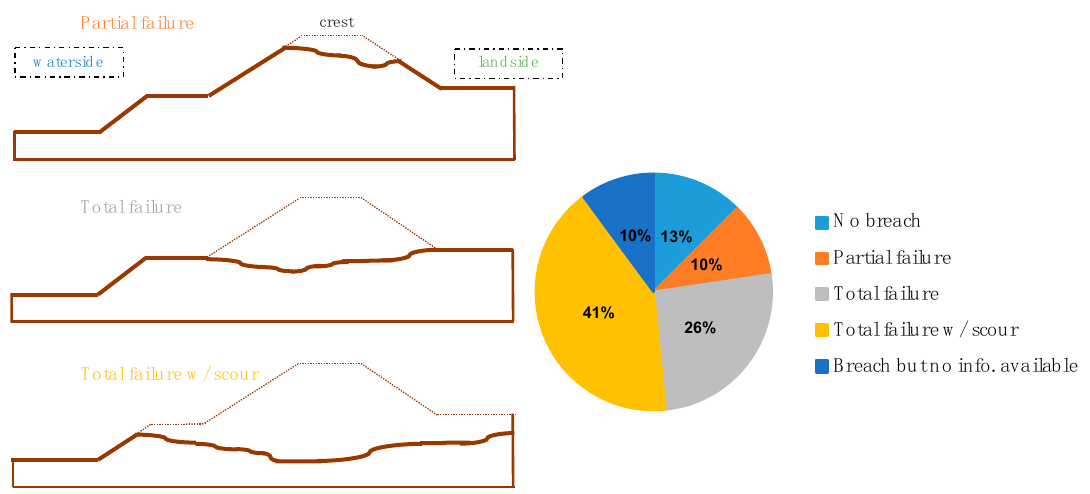
Figure 9. Damage degrees of the failed levees in Elbe region, Germany, 2002 and 2013 (adapted from [23).